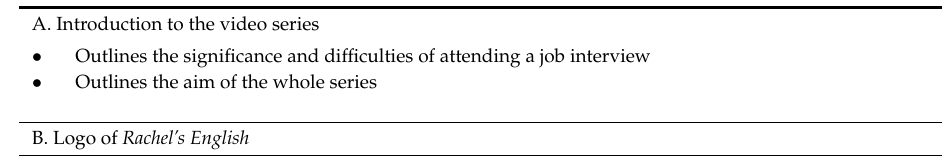
Table 2. The structure of a